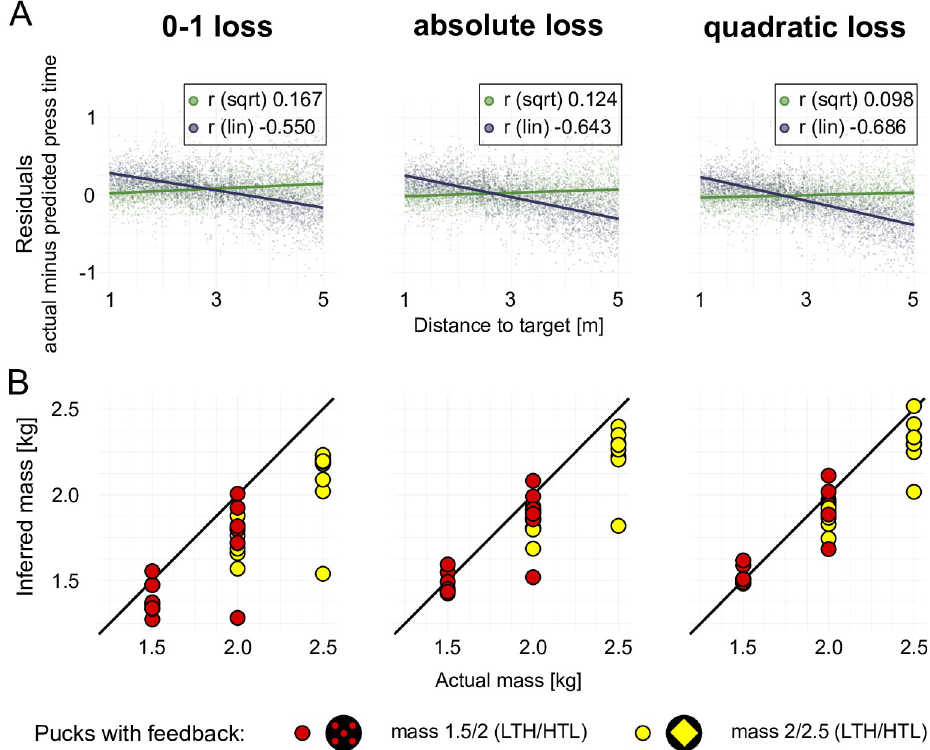
Fig 5. Residuals of estimated press times and inferred masses in phase two for three cost functions. (A) Residuals were calculated for each participant and each puck in phase two (”feedback”) given the actual press-times and the best fits for the linear heuristics and the Newtonian model. Residuals for both models were calculated for all three cost functions. (B) MAP estimates of the masses used by individual subjects inferred according to the Newtonian model for the the three cost functions. Red and yellow pucks had different masses for subjects in the two conditions “heavy-to- light” and “light-to-heavy”.